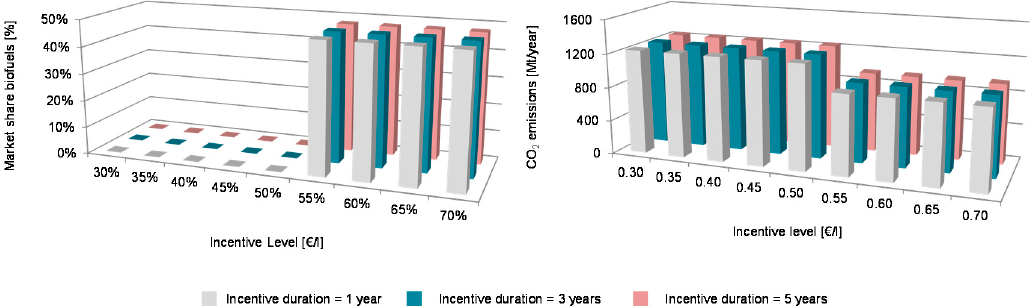
Figure 6. 2050 levels of market shares and CO 2 emissions for biofuels for different incentives levels and an incentive duration of one year (grey), three years (blue), and five years (red), respectively.